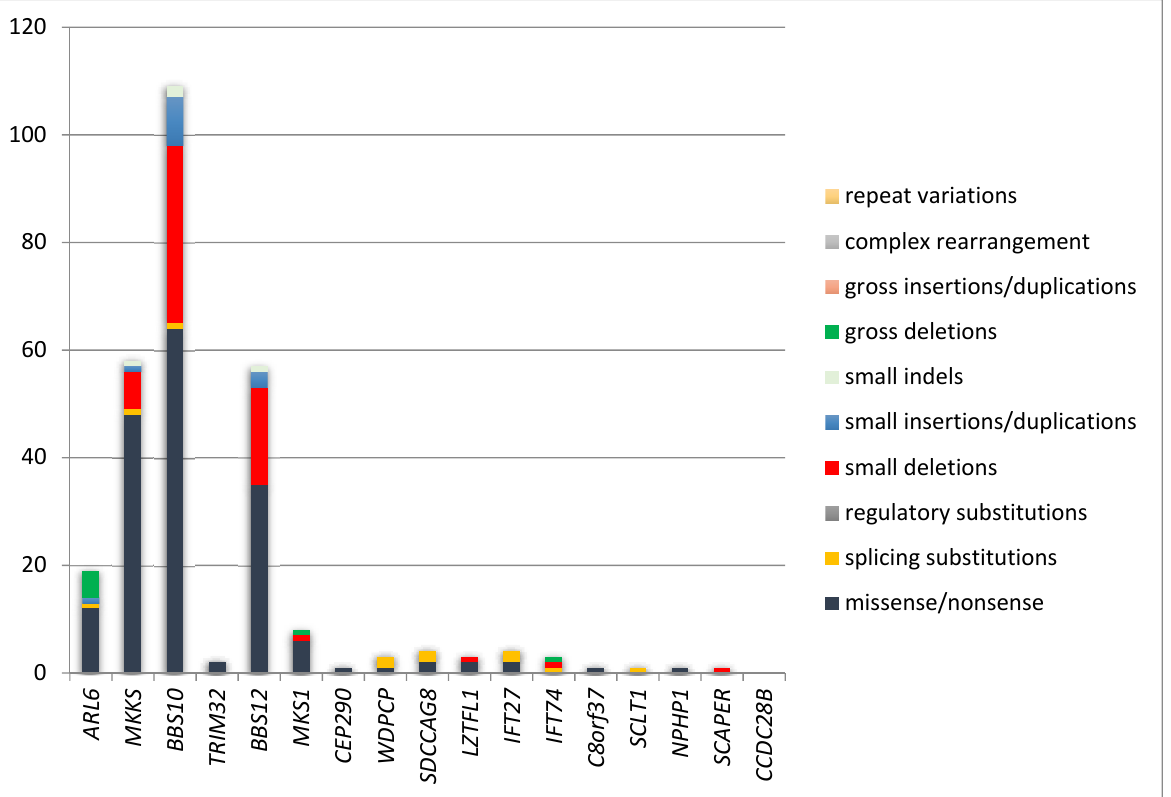
Figure 3. Pathogenic variants in other genes of BBS [34] . ARL6 : ADP ribosylation factor like GTPase 6; MKKS : MKKS centrosomal shuttling protein; BBS10 : Bardet-Biedl syndrome 10; TRIM32 : tripartite motif containing 32; BBS12 : Bardet- Biedl syndrome 12; MKS1 : MKS transition zone complex subunit 1; CEP290 : centrosomal protein 290; WDPCP : WD repeat containing planar cell polarity effector; SDCCAG8 : SHH signaling and ciliogenesis regulator SDCCAG8; LZTFL1 : leucine zipper transcription factor like 1; IFT27 : intraflagellar transport 27; IFT74 : intraflagellar transport 74; C8orf37 : chromosome 8 open reading frame 37; SCLT1 : sodium channel and clathrin linker 1; NPHP1 : nephrocystin 1; SCAPER: S-phase cyclin A associated protein in the ER.